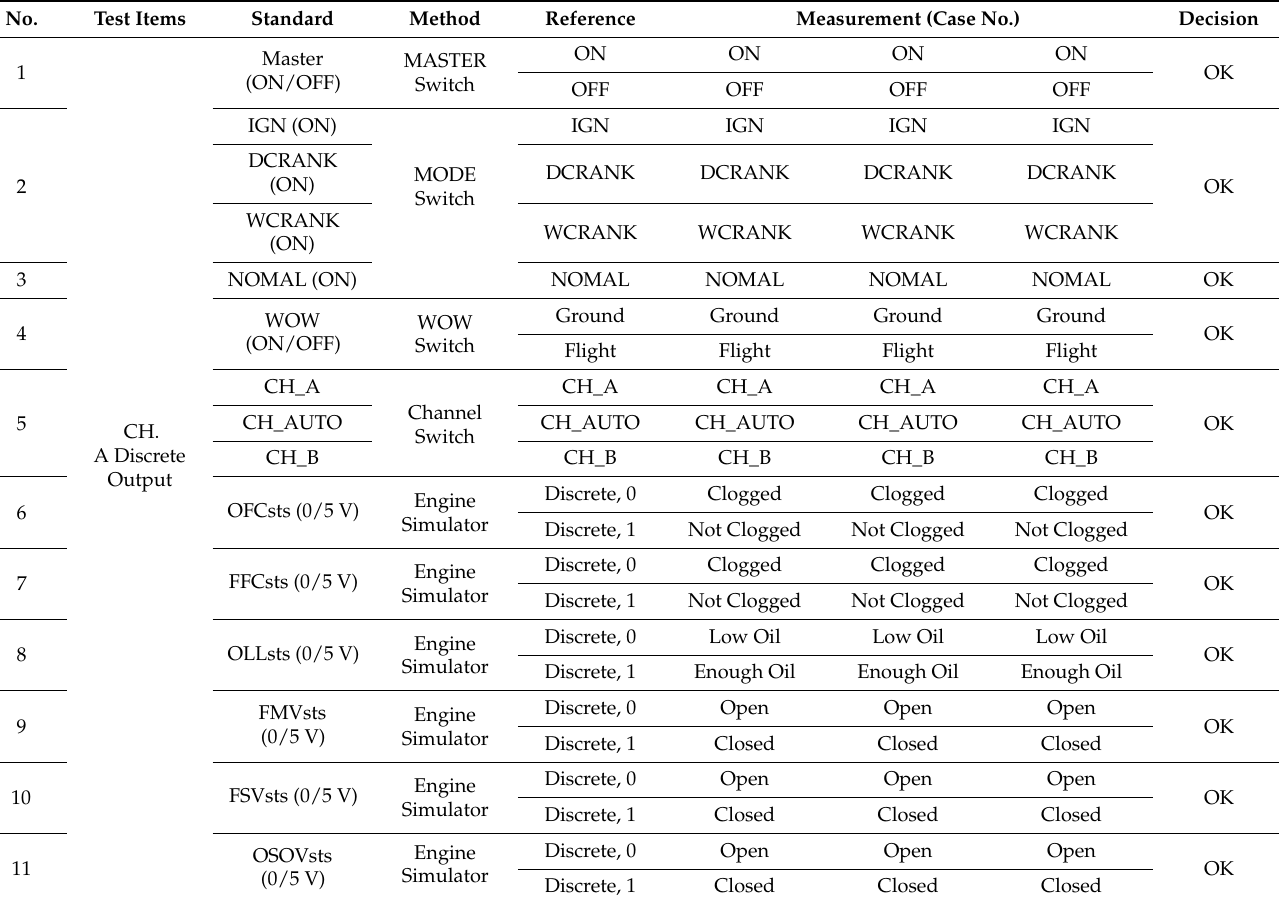
Figure 8. Process of interface test. Table 5. Result of interface and interworking test (discrete